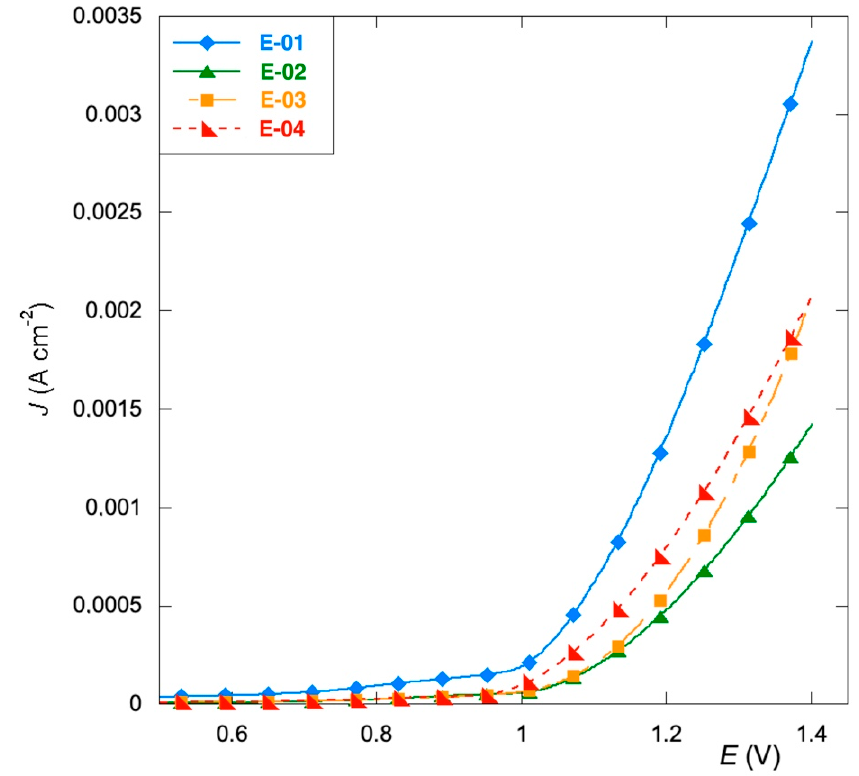
Figure 5. Linear sweep voltammetry recorded at 5 mV s − 1 in Na 2 SO 4 0.1 mol L − 1 .